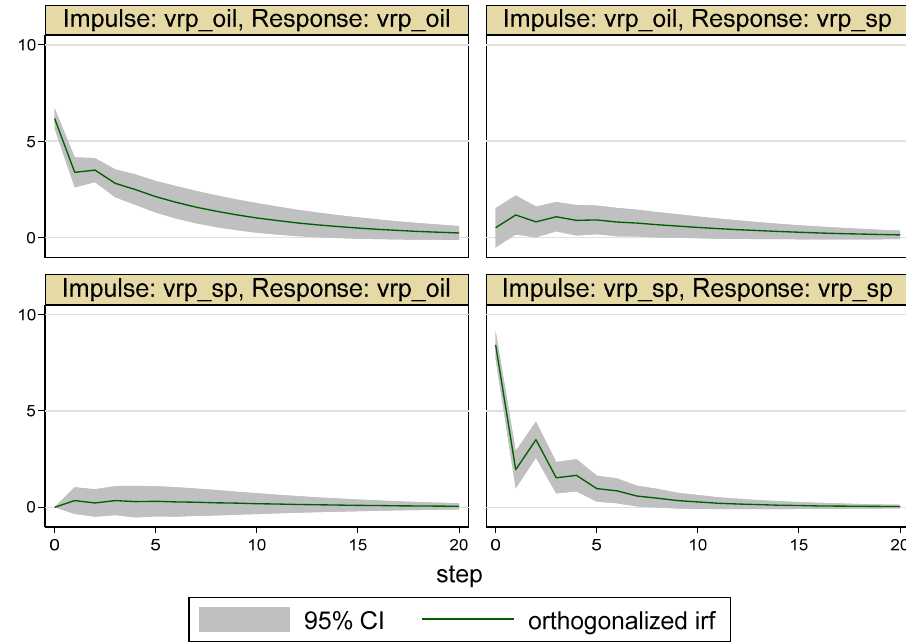
Figure 5. Impulse Response Function (Period 2).